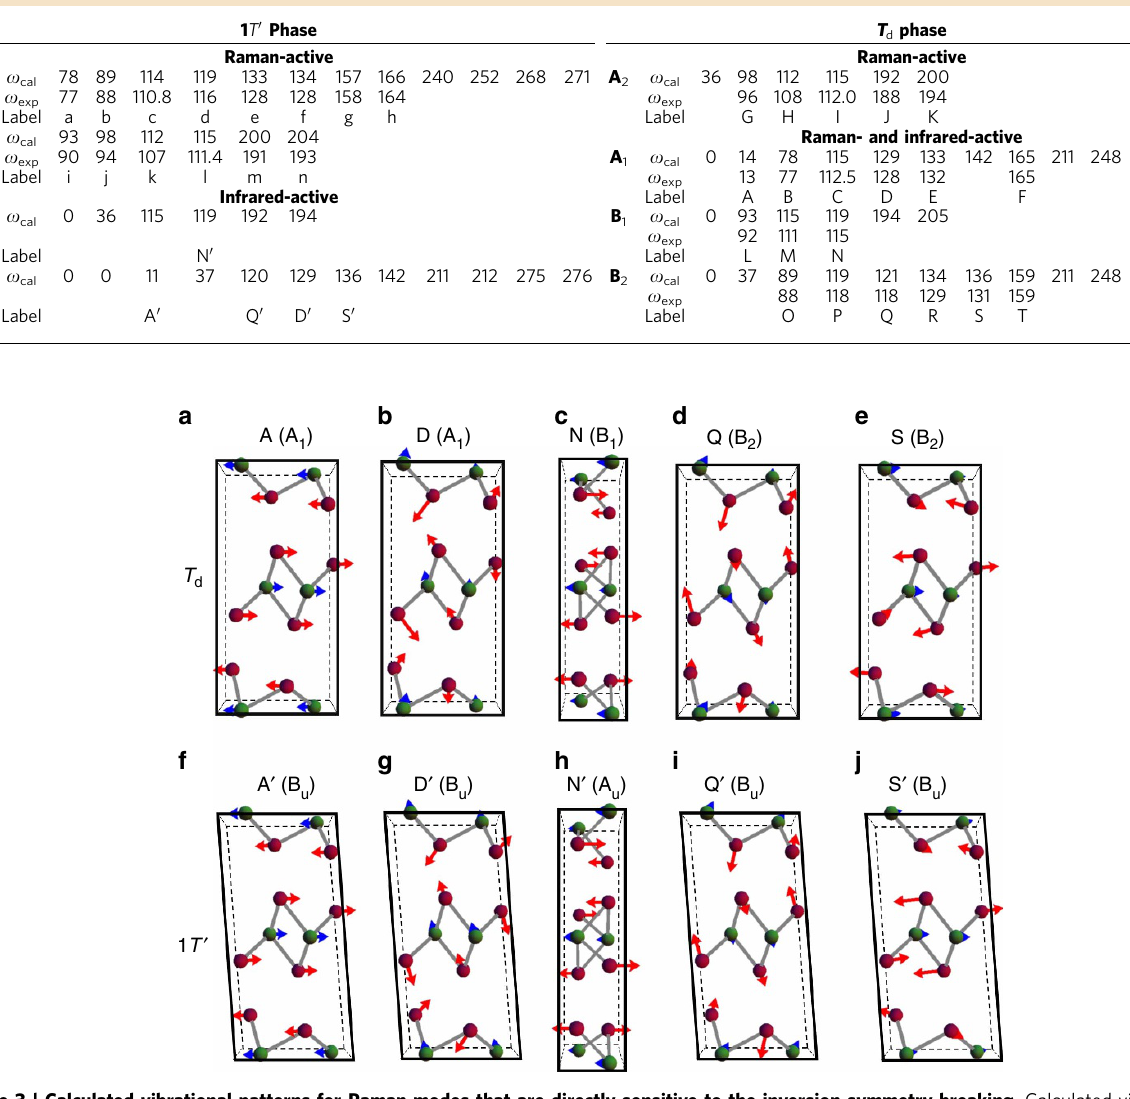
Table 1 | Comparison of the calculated and experimental Raman modes in the 1 T 0 and T d phases in units of cm (cid:2) 1 .